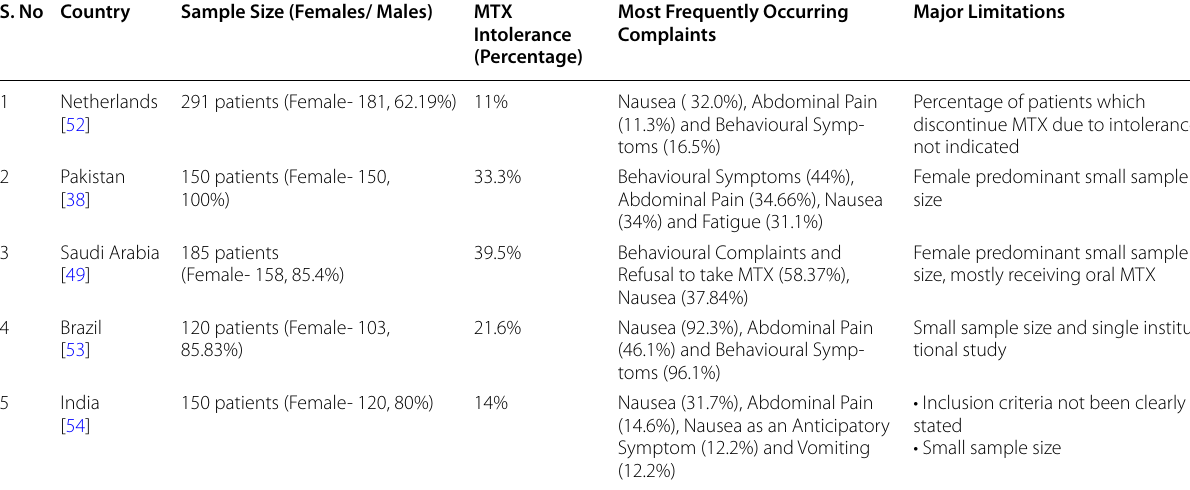
Table 1 Studies on prevalence of MTX intolerance in RA patients S. No